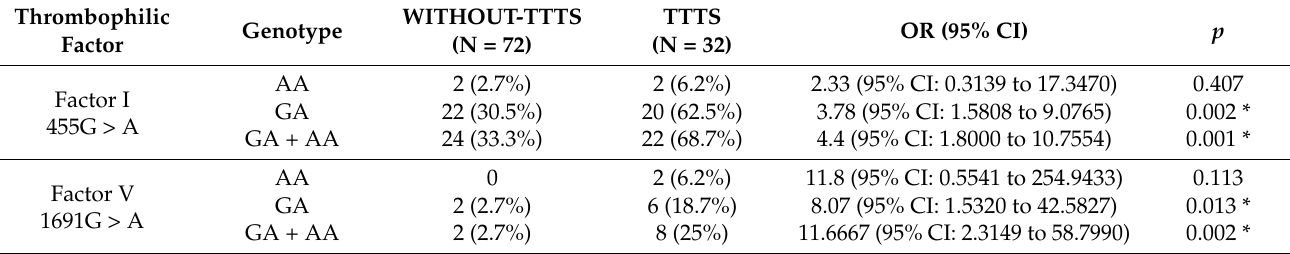
Table 2. Polymorphism frequency